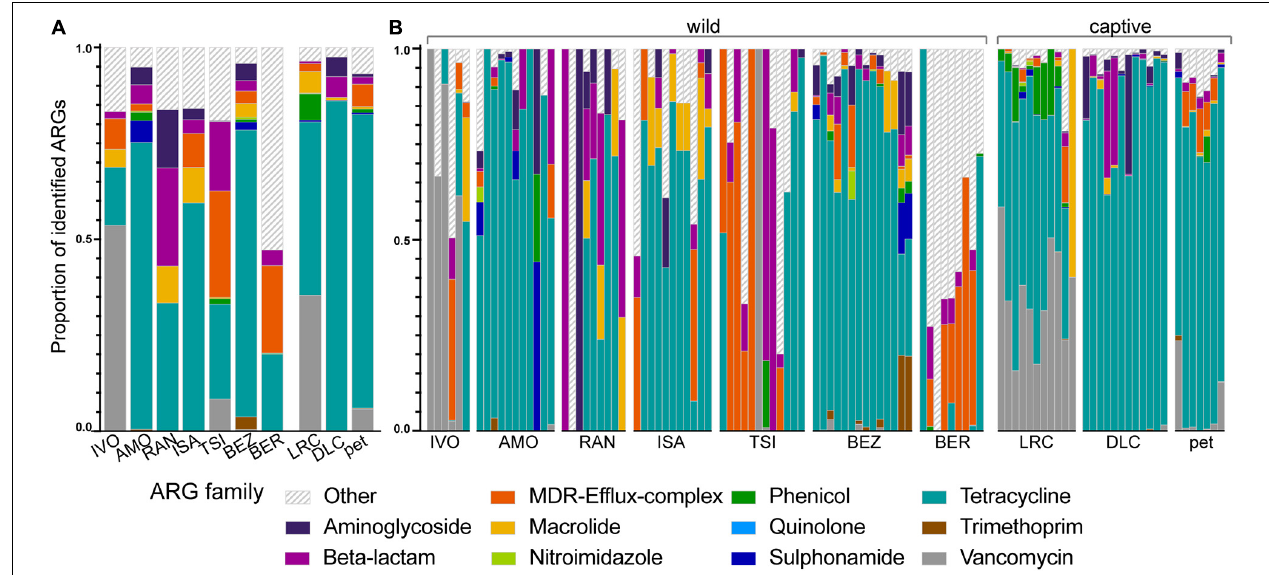
FIGURE 3 | The proportions of identified ARGs, categorized by gene family, in the gut microbiota of ring-tailed lemurs ( Lemur catta ) at seven natural habitats, two captive settings in Madagascar, and one captive setting in the United States. Data are shown (A) averaged by ‘site’ and (B) by individual lemur within sites. Gene families were identified by color and those representing < 1% of the ARGs were combined into the category “Other.” Sites are presented in ascending order according to the ranked level of anthropogenic disturbance ( Table 1